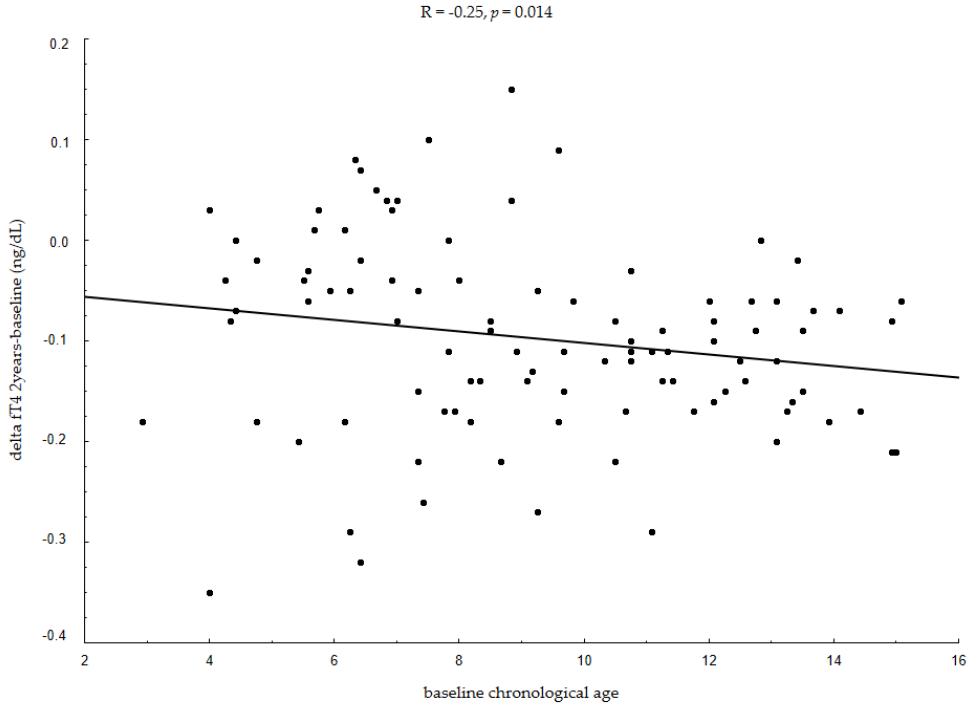
Figure 1. Associations between changes in fT4 levels in the first two years of rhGH therapy and baseline chronological age. fT4—free thyroxine; rhGH—recombinant human growth hormone; R—Spearman’s correlation coefficient.